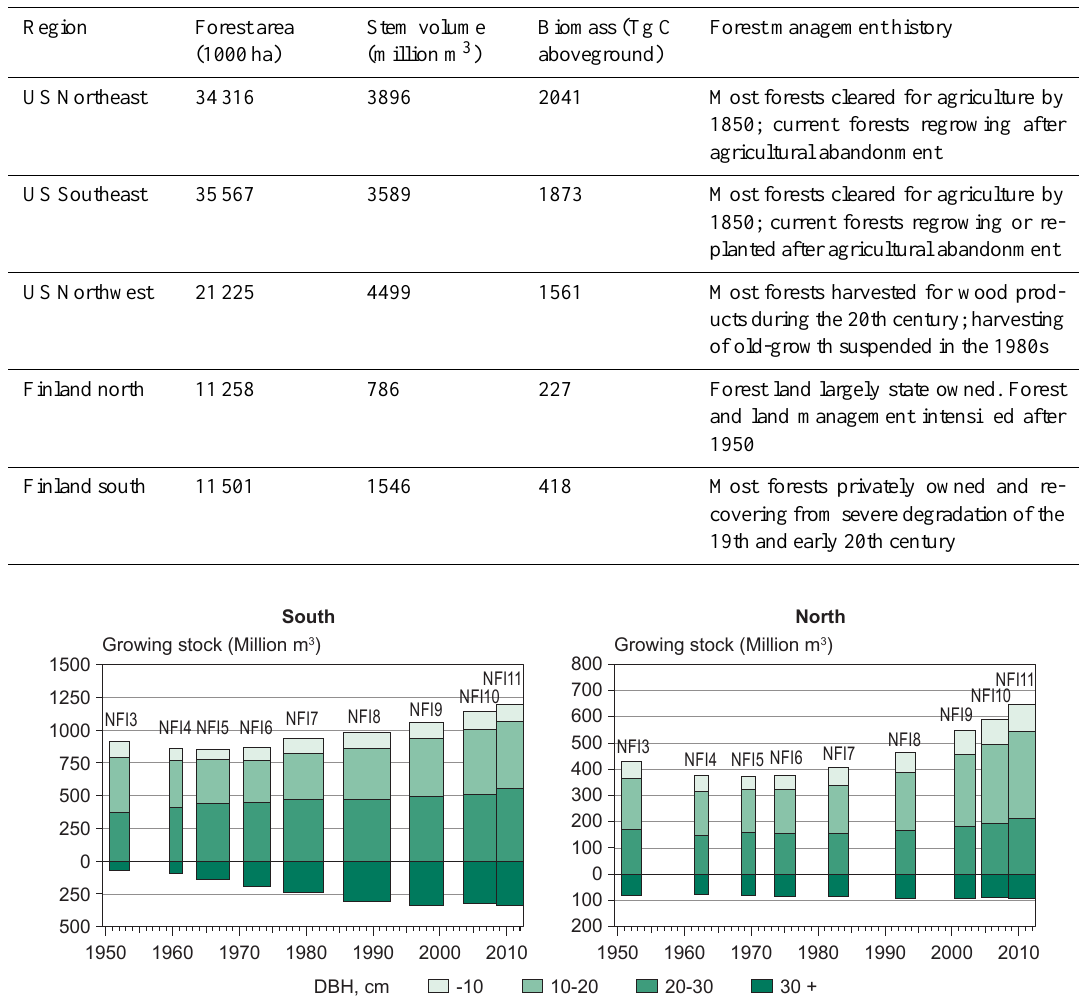
Figure 2. Dynamics of growing stock by tree size classes in regions “south” and “north” of Finland. NFI3 to NFI11 refer to the national forest inventory cycles from the 3rd to 11th cycle over the time span 1951 to 2012. The width of the bars refers to the observation years of each inventory cycle within the region. The stock of small trees is shown above the horizontal axis (DBH<30cm) – with the main change in north Finland beginning in the 1980s. The stock of large trees is shown in positive numbers below the horizontal axis (DBH>30cm) – with the main change in south Finland from 1951 to